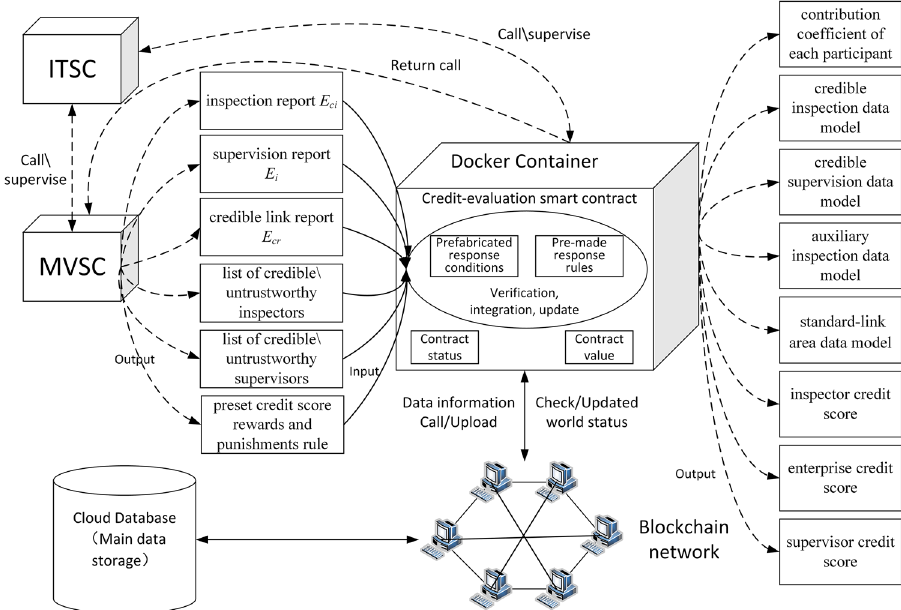
Figure 5. Logic diagram of the credit-evaluation smart